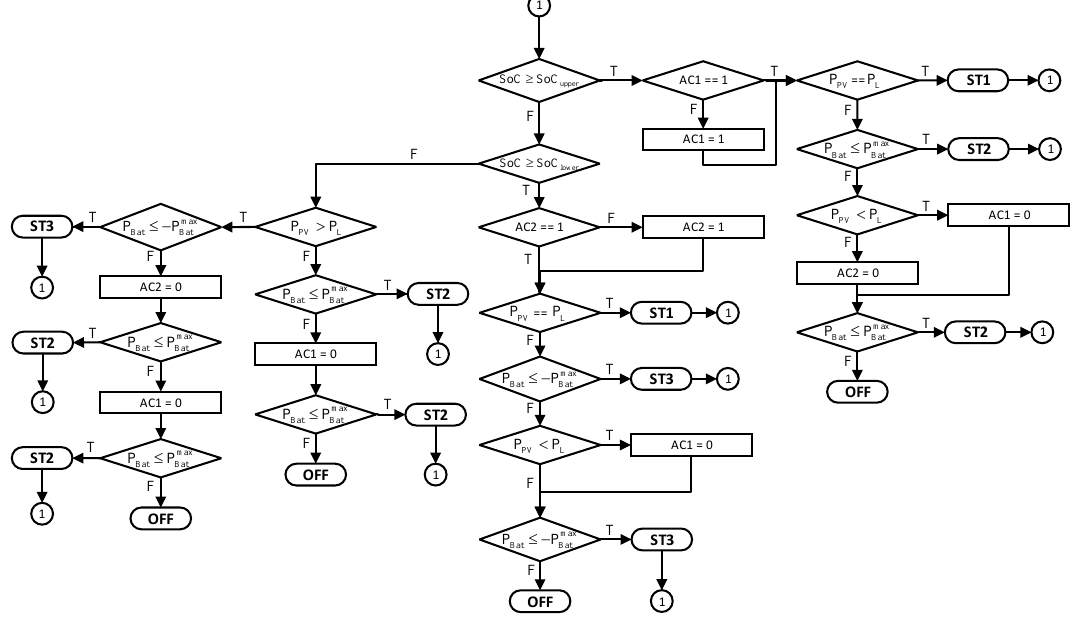
Figure 7. Flowchart of the proposed power management